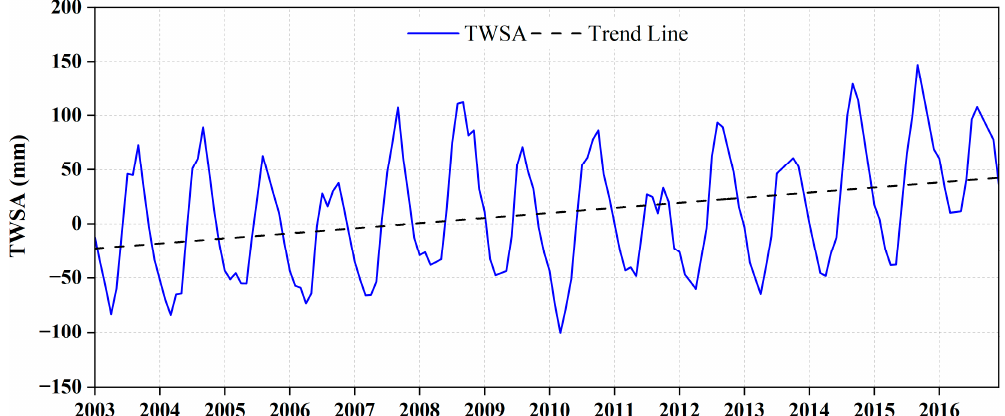
Figure 3. Time series of GRACE-derived terrestrial water storage anomalies from 2003 to 2016 in Southwest